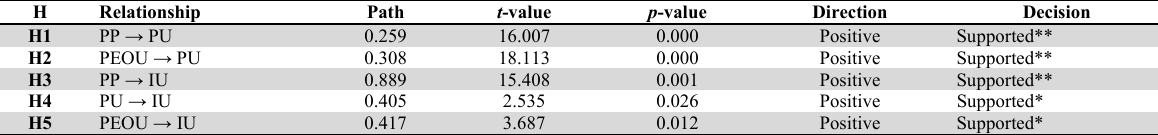
Results of structural modeling analysis.